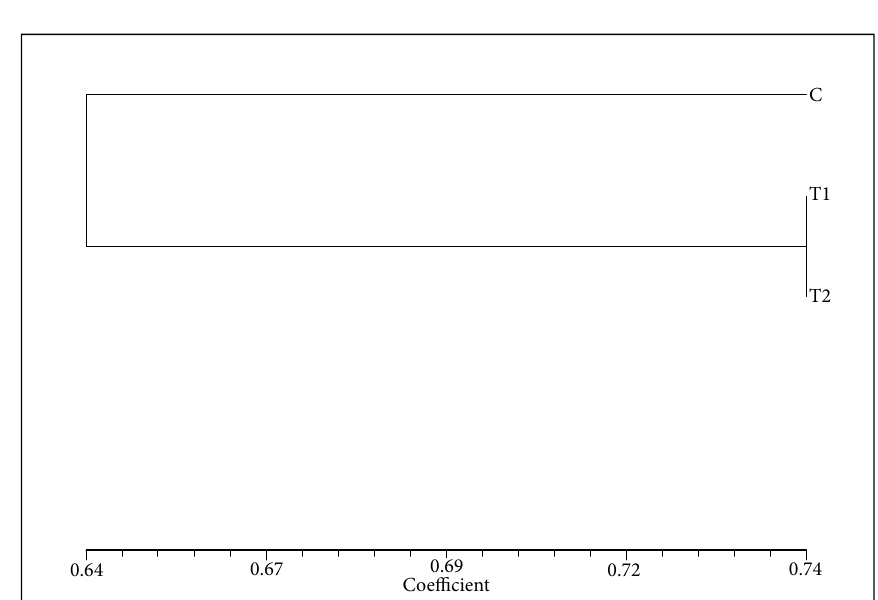
Fig. 4: Dendrogram obtained from analysis based on RAPD test via UPGMA method in